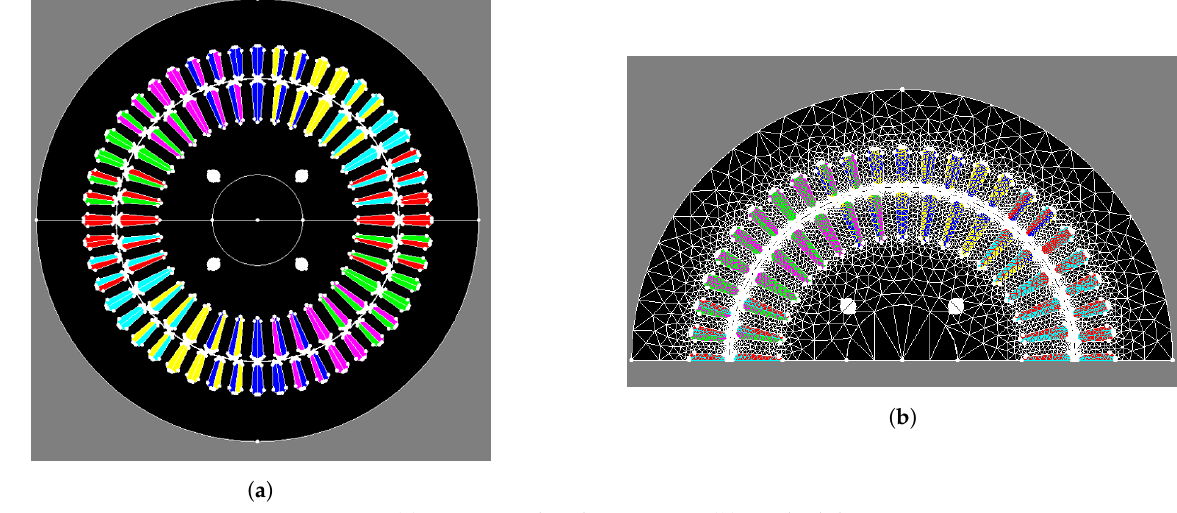
Figure 2. ( a ) WRIM rendered in FLUX2D ( b ) Meshed